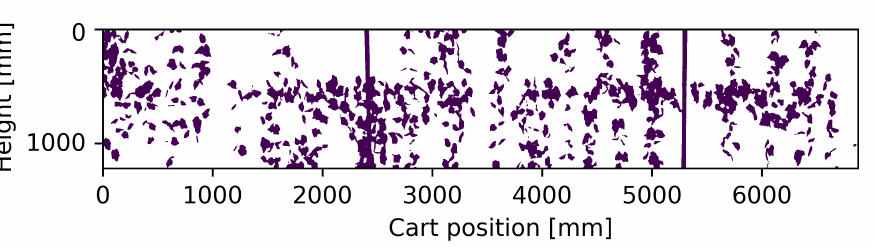
Figure 2. Processed ground-truth